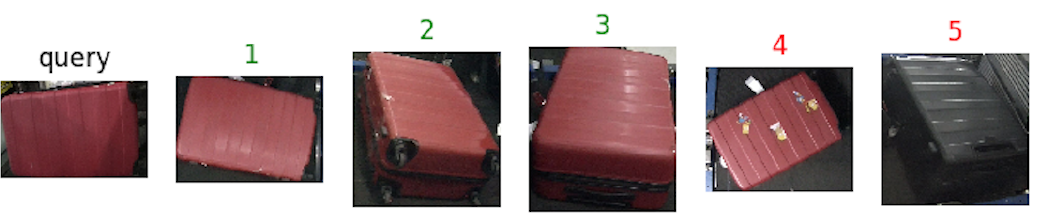
Figure 9. The results with EfficientNet-b5 as backbone. Green labels are correct query answers, while the red ones indicate different identities.